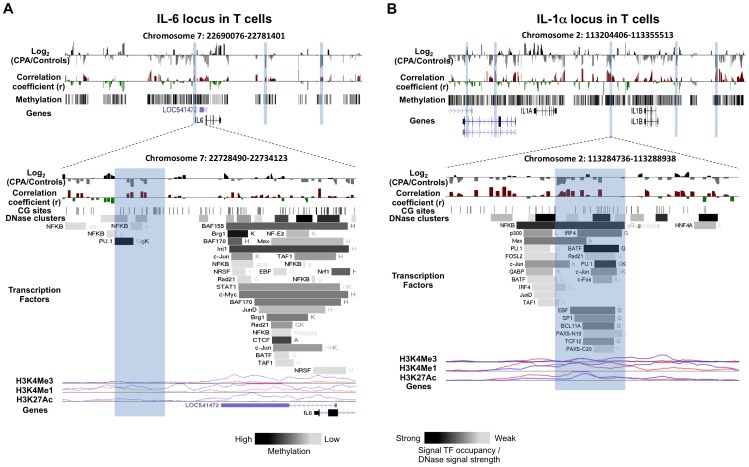
DNA methylation differences between CPA (n = 8) and control (n = 12) groups in pro-inflammatory cytokines IL-6 and IL-1α loci in T cells.Expanded views from the UCSC genome browser of IL-6 (A) and IL-1α (B) loci located on chromosomes 7 and 2 are depicted (top panel). In both panels, the first track shows the average MeDIP probe log2-fold differences (scale top panel: −0.4 to 0.4, botom panel: −1.0 to 1.0) between chronic physical aggressive (CPA) and control groups for T cells. In black are probes that are more methylated and in gray are those that are less methylated in the CPA group. Highlighted in blue are regions significantly differentially methylated between the groups. The second track shows Pearson’s correlation coefficient values (scale top panel: −0.4 to 0.4, botom panel: −0.7 to 0.7) calculated between the MeDIP microarray probe intensities and the plasma IL-6 (A) and IL-1α (B) levels obtained from the same subjects (n = 20). In red are probes whose methylation levels correlate positively with the cytokine level in plasma and in green are those that correlated negatively. In the top panel, the lowest track shows the average methylation level for all the subjects in T cells estimated from the microarray data. The bottom panel zooms on the closest region upstream of the TSS where the CPA group is found significantly less methylated than the control group in the IL-6 (A) and IL-1α (B) loci. In both regions, an overall positive correlation between methylation and cytokine level in plasma is observed but only reached significance after correcting for multiple testing in IL-1α (B) differentially methylated region. The regulatory elements from ENCODE identified in these regions (see methods) are shown in the additional tracks. First, shown with black lines, is the location of individual CpG sites. Second, is the location of DNase hypersensitive clusters where black indicate strong signal and grey a weaker signal from ChIP-seq data in 24 cell lines. Third is the location of transcription factors (TF) identified from ChIP-seq data in 24 cell lines where black indicate a strong and grey weaker signal occupancy. The letter next to the TF boxes identified the cell line where it was found enriched (see Table S1 for the full legend). The last tracks, identified the level of enrichment of three histone marks determined from ChIP-seq assay, histone 3 lysine 4 tri- and mono-methylation as well as histone 3 lysine 27 acetylation in two cell lines, GM12878 (pink) and K562 [106].